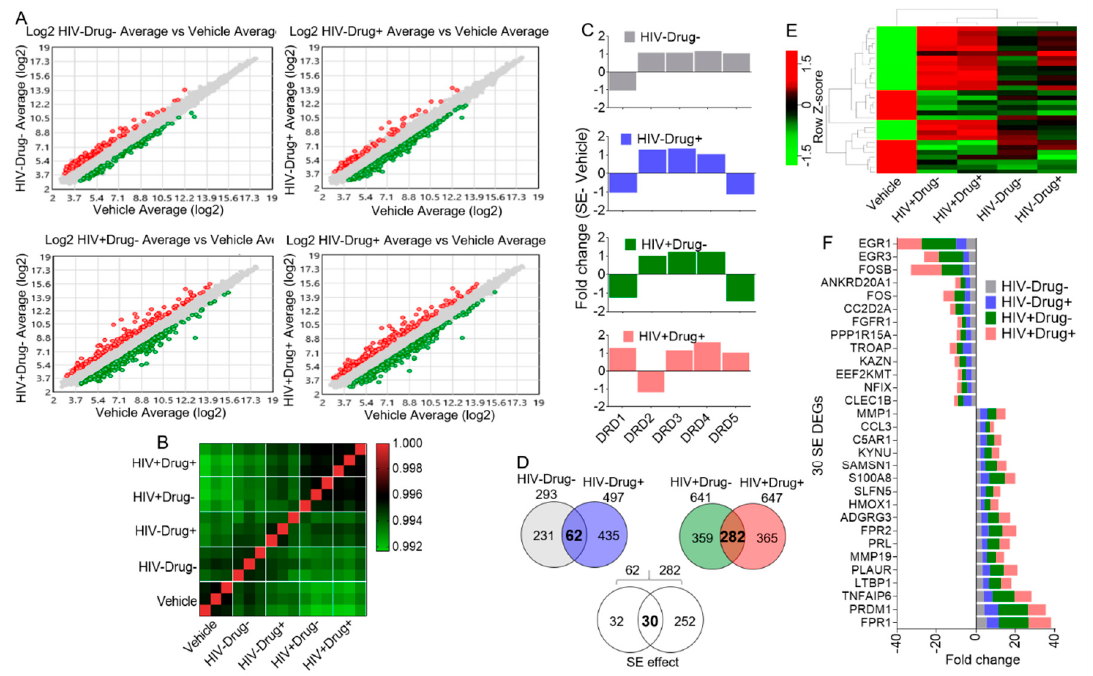
Figure 2. Microarray analysis of monocytes (n = 15) treated with vehicle or SE from different clinical groups (triplicate per treatment): ( A ) Scatter plots of the different SE treatments compared to the vehicle control. Red and green dots correspond to the significantly up- and downregulated genes, respectively. Gray dots correspond to the unchanged genes. ( B ) Correlation matrix of all genes (21448) showing a differential pattern in monocyte gene expression. ( C ) Gene expression levels of dopamine receptors as determined by microarray analysis. Differences were not significant with the set filtration criteria of fold change (FC) < − 2 or FC > 2 and P-value < 0.05 (Benjamini and Hochberg correction for multiple observations). ( D ) Venn diagram analysis showing 30 differentially expressed genes (DEGs) common to all SE (HIV − Drug − , HIV − Drug+, HIV+Drug − , HIV+Drug+) treatments. The bold fonts in the Venn diagrams are the numbers of interest. ( E ) Hierarchical clustering heatmap showing the overall expression of the 30 SE-DEG. ( F ) Bar graph showing the fold change of each of the 30 SE-DEGs as compared to vehicle. Table 3. Summary of the DEG in the four clinical groups (n = 3) as compared to vehicle 1 . Upregulated Downregulated Genes passed filter criteria 1 % of total genes 2 # of % of DEG # of genes % of DEG genes